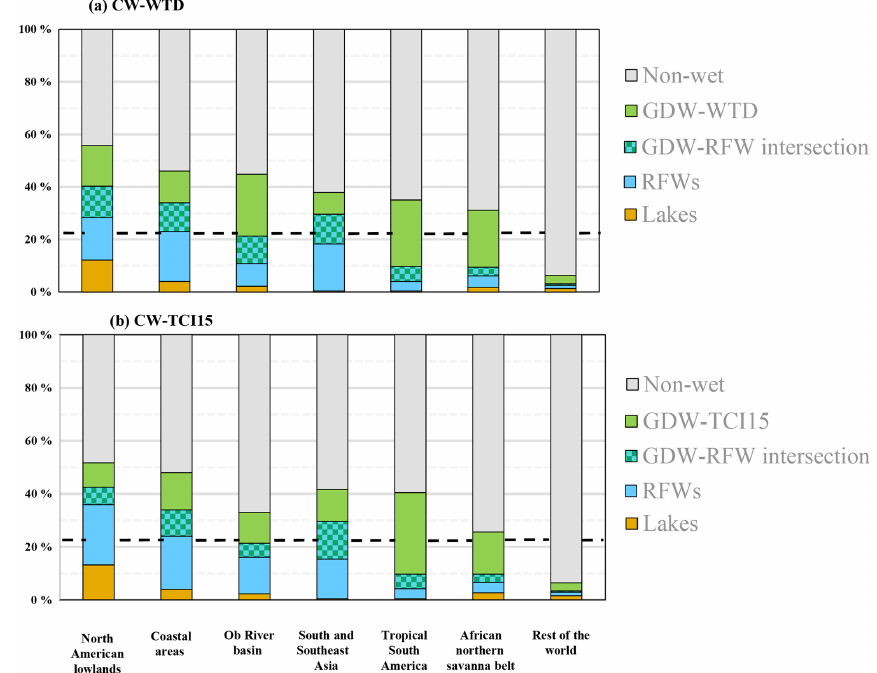
Figure 14. Contribution of non-wet areas, lakes, RFWs, GDWs and their intersection in the wetland hotspot window shown in Fig. 13 (a) in CW-WTD and (b) in CW-TCI15. The dashed line shows the average global wetland fraction, equal to 21.1% in (a) and 21.6% in (b)